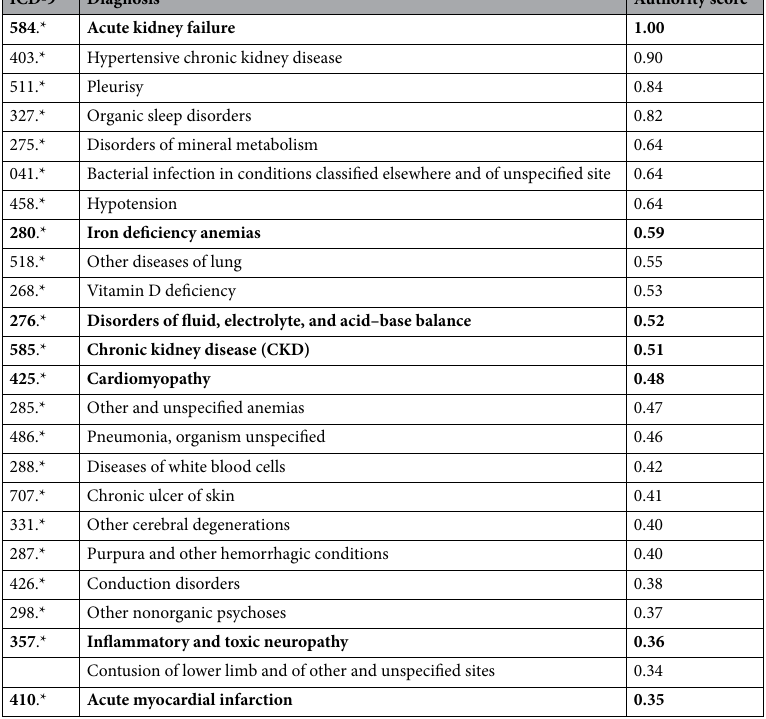
bacterial infection in conditions classified elsewhere and of unspecified site (041.*) (Table 5). Several diagnoses had high hub, authority, and PageRank scores, including acute kidney failure (584.*), iron deficiency anemia (280.*), fluid, electrolyte, and acid–base balance disorders (276.*), and chronic kidney disease (585.*). We more closely investigated the diagnoses with the top hub and authority scores to better contextualize their comorbiditiy. ICD 411.* (other acute and subacute forms of ischemic heart disease) had the highest hub score, and commonly preceded a number of expected diagnoses, including cardiac (acute myocardial infarction, car- diomyopathy) and renal (acute kidney failure, hypertensive chronic kidney disease) diagnoses (Supplementary Table S2; Fig. 2). Other subsequent diagnoses to ischemic heart disease included those with similar vascular etiologies (e.g., occlusion and stenosis of precerebral arteries and acute cerebrovascular disease). Other high relative risk diagnoses included organic sleep disorders, iron deficiency anemia, other diseases of the lung and pleurisy. These may share more distant causal etiologies such as smoking (lung disease) or be indirectly related due to intermediary comorbidities (e.g., renal disorders resulting in anemia). Acute kidney failure (ICD 584.*) had the highest authority and PageRank scores, representing one of the most common subsequent diseases. Diagnoses which carried a high relative risk for subsequent diagnosis of acute included expected diagnoses such as essential hypertension, chronic renal dysfunction (chronic kidney disease, hypertensive chronic kidney disease, other disorders of kidney and ureter), cardiac disease (heart failure, ischemic heart disease), and diabetes (Supplementary Table S3; Fig. 3). Correlated sequelae of chronic renal dysfunction such as electrolyte disorders and anemia were also observed. Finally, a number of less clinically anticipated diagnoses carried a high relative risk of subsequent acute kidney failure, including gout, chronic ulcer of the skin, and inflammatory and toxic neuropathy. The greatest RR relationships were used to generate sample diagnosis paths from the highest hub diagnosis, other acute and subacute forms of ischemic heart disease (ICD 411.*), demonstrating a rational pathway to chronic pulmonary heart disease (ICD 416.*) (Supplementary Figure S1). Similarly, the greatest RR relationships were investigated to create a path to acute kidney failure (ICD 584.*), which had the highest authority score. This demonstrated a progression from diabetes mellitus (ICD 250.*) with aggregation of other diabetic complications (neuropathy, hypertension) before reaching acute kidney failure. Infomap identified four communities of diagnoses (Fig. 1; Supplementary Table S4). One was primarily neuropsychiatric, including disorders of the inner ear (380.*), persistent mental disorders due to conditions classified elsewhere (294.*), other nonorganic psychoses (298.*), and other cerebral degenerations (331.*). The second was cerebrovascular in nature, with acute, but ill-defined cerebrovascular disease (436.*), late effects of cerebrovascular disease (438.*), and transient cerebral edema (435.*). A third community included ear disorders, with hearing loss (389.*) and other disorders of the ear (388.*), and the fourth one included all other diagnoses.